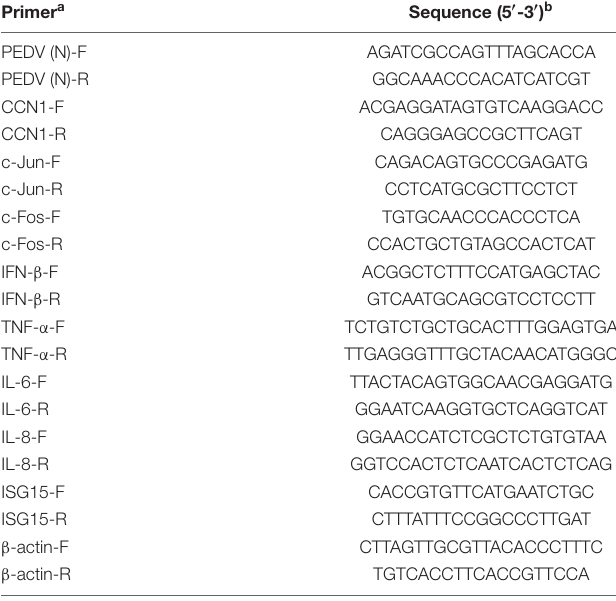
TABLE 3 | List of primers for